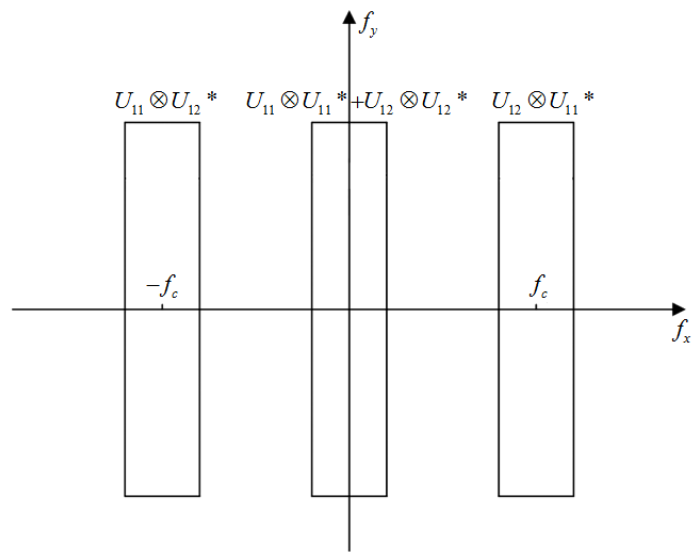
Figure 7. Schematic of the Fourier spectrum of the image.